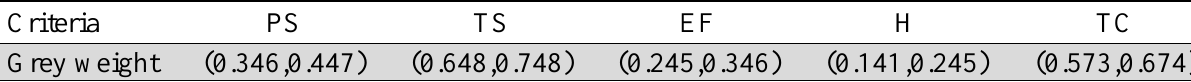
Grey weights for mechanical properties of copper alloys Criteria Grey weight